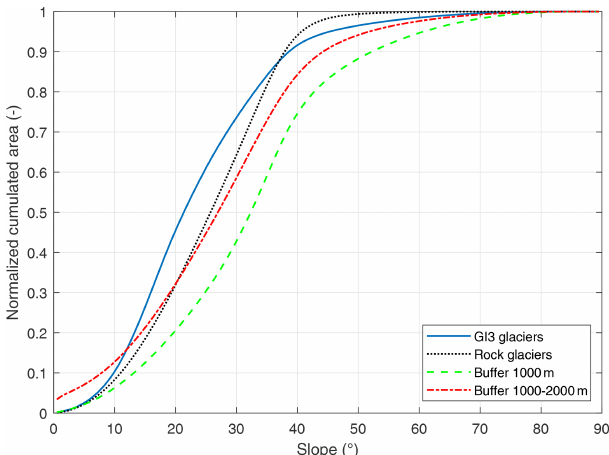
Figure 6. Distribution of slopes for glaciers, rock glaciers and the two buffer areas used for validation. The buffer regions are steeper than the glaciers, so that the elevation difference in the stable buffer zones can be considered an upper limit for the